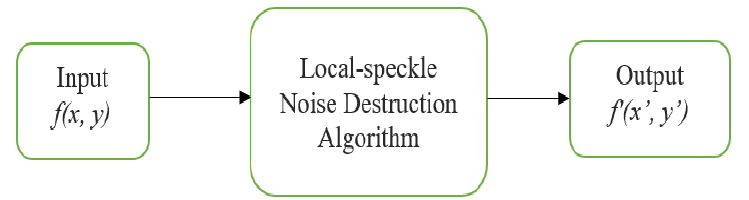
Figure 4. Algorithm 1 for noise removal of the local speckle